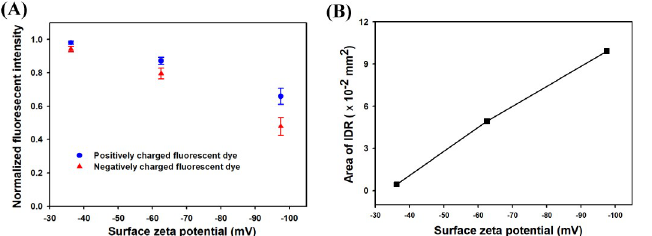
Fig 4. Formation of IDZ near the charged membranes. (A) The normalized fluorescent intensities of PFD and NFD were measured, respectively. (B) The IDZ area defined as the region whose intensity was lower than 220 was calculated.